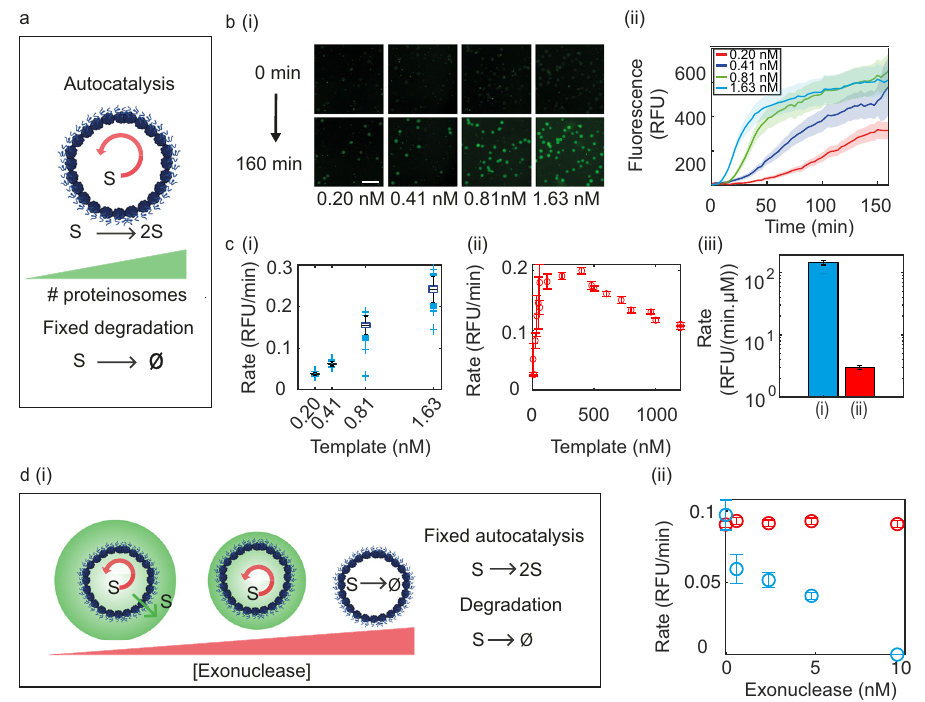
Fig. 4 Characterisation of autocatalytic PEN DNA reactions within proteinosomes. a Increasing overall template concentration at fi xed exonuclease concentration (0.6 nM). b (i) Fluorescence wide fi eld microscopy images, at t = 0 min and 160 min, showing proteinosome populations at different densities resulting in total DNA template concentration of 0.20 – 1.63 nM. Images are a representation from a single experiment. Scale bar is 100 μ m. (ii) Autocatalytic kinetic curves from microscopy images. Bold line is the average kinetic pro fi le from 54, 67, 99 and 436 proteinosomes for total DNA concentrations of 0.20 (red), 0.41 (blue), 0.81 (green), 1.63 nM (cyan) respectively. Shaded region is the standard deviation. c Reaction rates for autocatalytic reactions carried out with varying template concentration in (i) proteinosomes, box plots show the the median, fi rst and third quartile and upper and lower adjacent values. The blue data points are the outside points. Plots are from 107, 162, 370 and 669 proteinosomes. (ii) In buffer solution. The initial rates were obtained from fi tting of the kinetic pro fi les and plot as a function of template concentration. Error bars represent the error from the fi t. (iii) Bar chart shows the linear fi t of autocatalytic reaction rate per template (d r /d[ T ]) for (i) proteinosomes (144.5 ± 44.0 RFU min − 1 μ M − 1 ) (blue), (ii) buffer (1.6 ± 0.3 RFU min − 1 μ M − 1 ) (red). Error is obtained from the fi t to the data. d (i) with constant template concentration and increasing exonuclease concentration, the exonuclease degrades the substrate inside and outside of the proteinosomes. With high exonuclease concentration, the reaction will be completely switched off. (ii) Initial rates of autocatalytic reaction with increasing exonuclease concentration in proteinosomes (blue squares) and a buffer solution (red circles). Rates and standard deviations were obtained from fi ts to the kinetic pro fi les. Data obtained from one experiment. Source data are provided in the source data fi